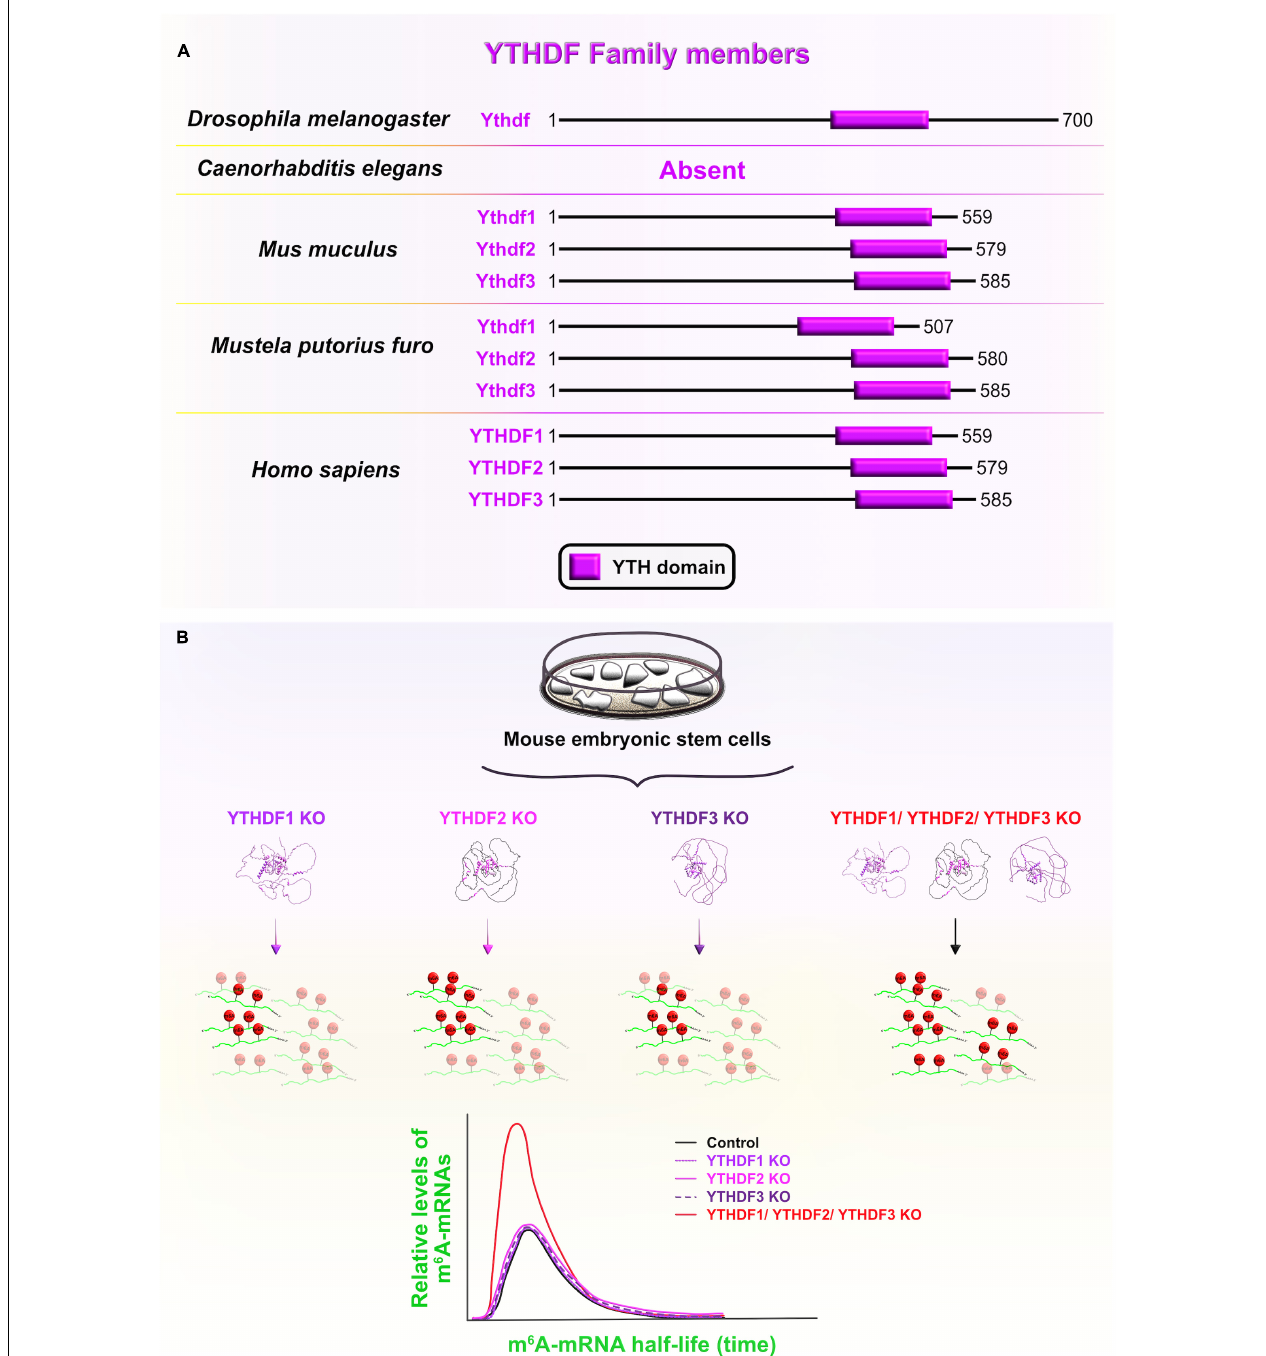
FIGURE 10 | YT521-B homology domain-containing family (YTHDF) members and functional redundancy between YTHDF proteins. (A) Schematic presentation of RNA-binding YT521-B homology (YTH) domain (labeled in fuchsia) in evolutionarily conserved YTHDF members in Drosophila melanogaster , Mus musculus , Mustela putorius furo , and Homo sapiens consistent with UniProt database (https://www.uniprot.org). The UniProtKB accession numbers are indicated below for YTHDF protein in D. melanogaster : Ythdf (Q9VBZ5), M. musculus : Ythdf1 (P59326), Ythdf2 (Q91YT7), Ythdf3 (Q8BYK6); M. putorius furo : Ythdf1 (M3Y9P7), Ythdf2 (M3YVM9), Ythdf3 (M3YEM5); and H. sapiens : YTHDF1 (Q9BYJ9), YTHDF2 (Q9Y5A9), YTHDF3 (Q7Z739). (B) YTHDF paralogs (YTHDF1–3) promote N 6 -methyladenosine (m 6 A)-tagged mRNA decay in a largely redundant fashion. Only when all three cytoplasmic paralogs are deleted from mouse embryonic stem cells in vitro , the half-life of m 6 A-modified transcripts was significantly increased compared to non-methylated mRNAs, implying a significant decrease in the m 6 A-mediated degradation rate. This functional redundancy of the three paralogs is associated with their sequence similarities and shared mRNA target specificities. The predicted tertiary and secondary full-length protein structures of YTHDF paralogs in Homo sapiens are adopted from https://www.uniprot.org: YTHDF1 (Q9BYJ9); YTHDF2 (Q9Y5A9); YTHDF3 (Q7Z739).